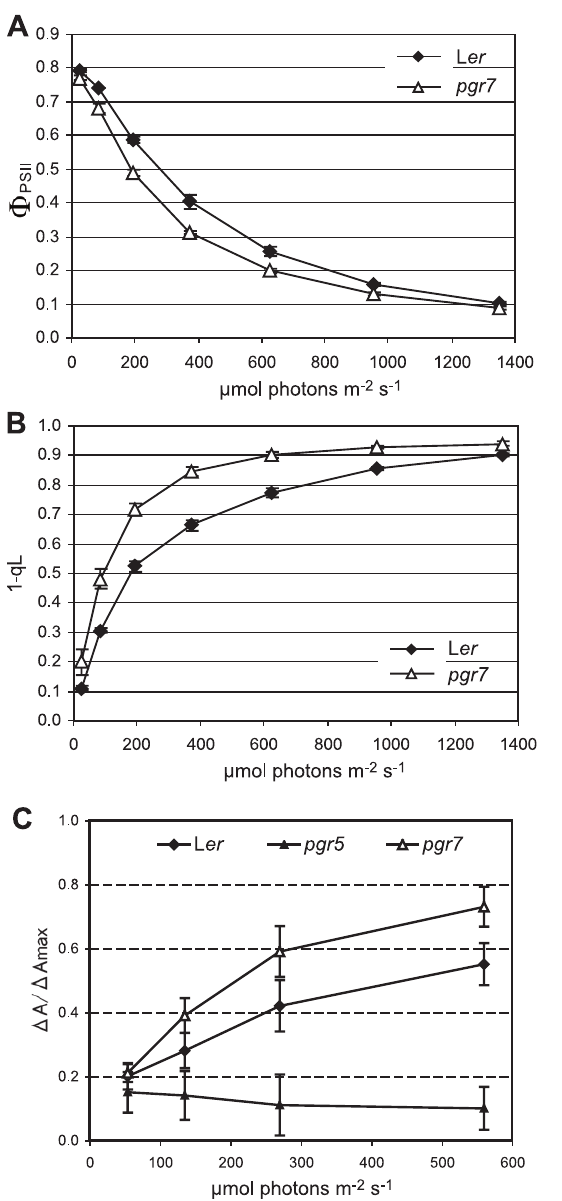
Figure 3. Light responses of W PSII , 1-qL and D A/ D Amax in the pgr7 mutant. Chlorophyll fluorescence parameters and P700 + absorbance were measured from attached rosette leaves during a 5 min illumination with each of the corresponding light intensities. Each data point is the mean 6 SD (n=3 except for n=6 of pgr7 in C). A) Quantum yield of PSII ( W PSII ) of pgr7 and L er . B) Reduction state of PSII (1-qL) in pgr7 and L er . C) Redox state of the reaction center chlorophylls of PSI (P700). D A/ D Amax was determined by absorbance changes at 820 nm.